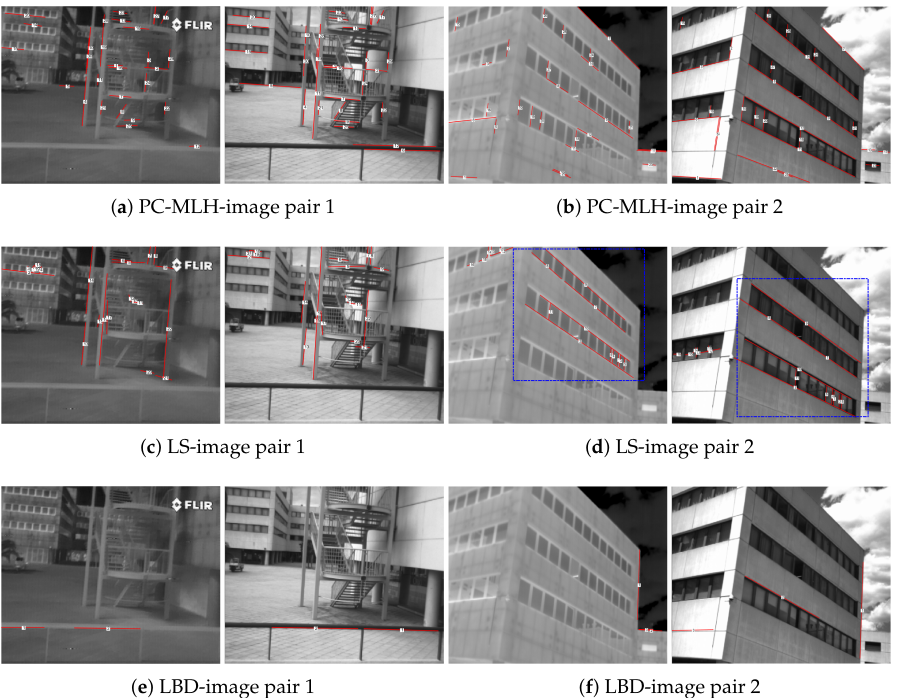
Figure 10. Performance comparison of PC-MLH, LS, and LBD on two LWIR-VS image pairs. In ( a – f ), the left and right images are LWIR and VS images, respectively. ( a , c , e ) are the results of image pair 1; ( b , d , f ) are the results of image pair 2. Both of the VS and LWIR images were converted to corresponding greyscale images before the process of line segment